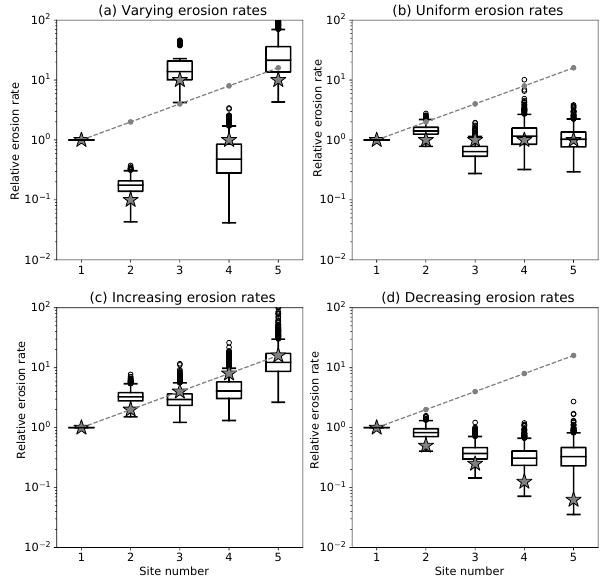
Figure 5. Results of the method applied to the second set of syn- thetic datasets with increasing F i = A i α i downstream. See Fig. 3 caption for further